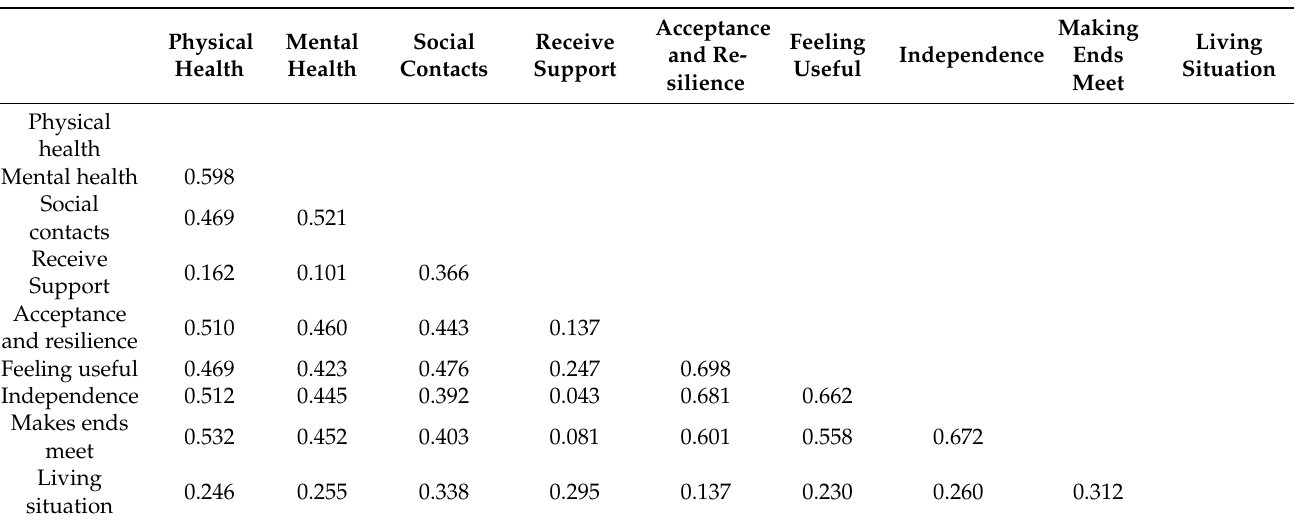
Figure 1. Response distributions (as percentage) by WOOP items, n = 353. Table 2. Spearman correlations among WOOP items, n =